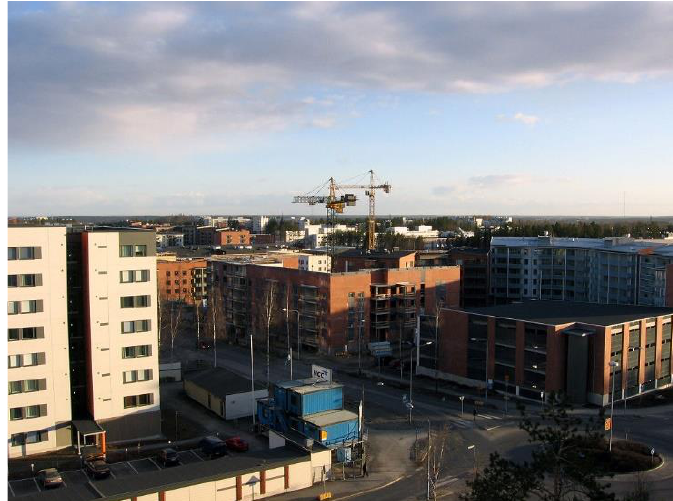
Figure 2. Hervanta (source: Wikipedia).